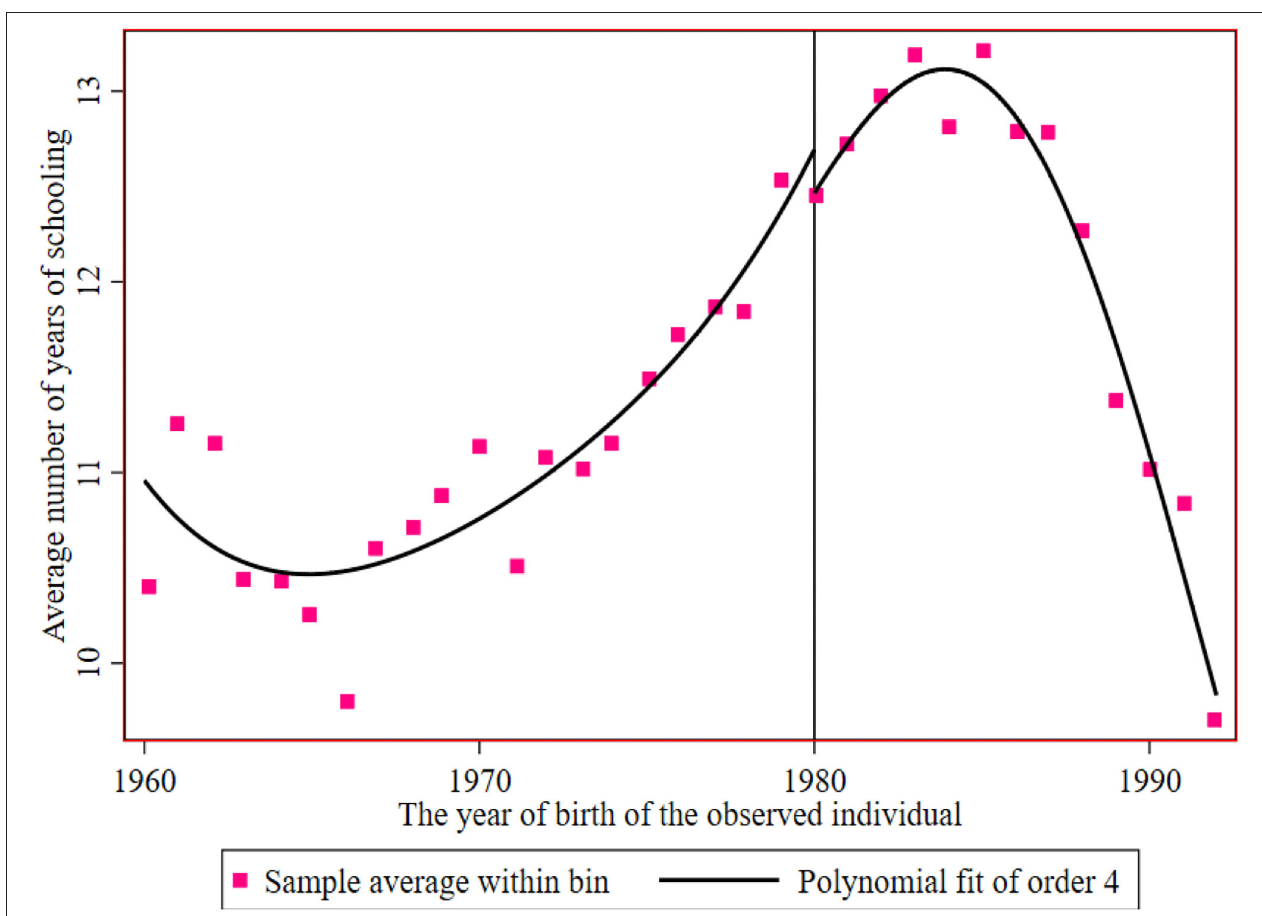
FIGURE 4 | The educational breakpoint of urban residents before and after the implementation of the reproductive health